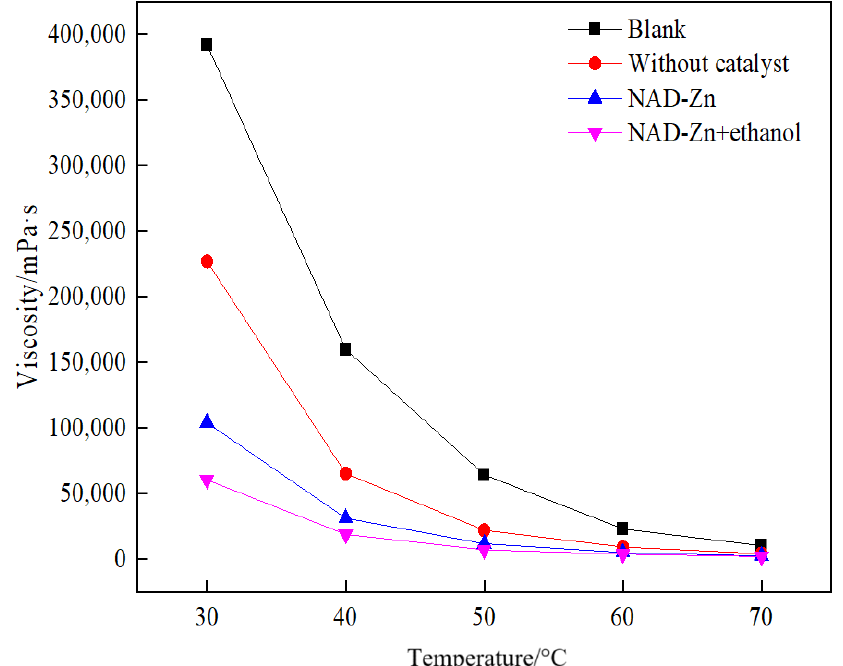
Figure 3. Effect of ethanol on aquathermolysis.